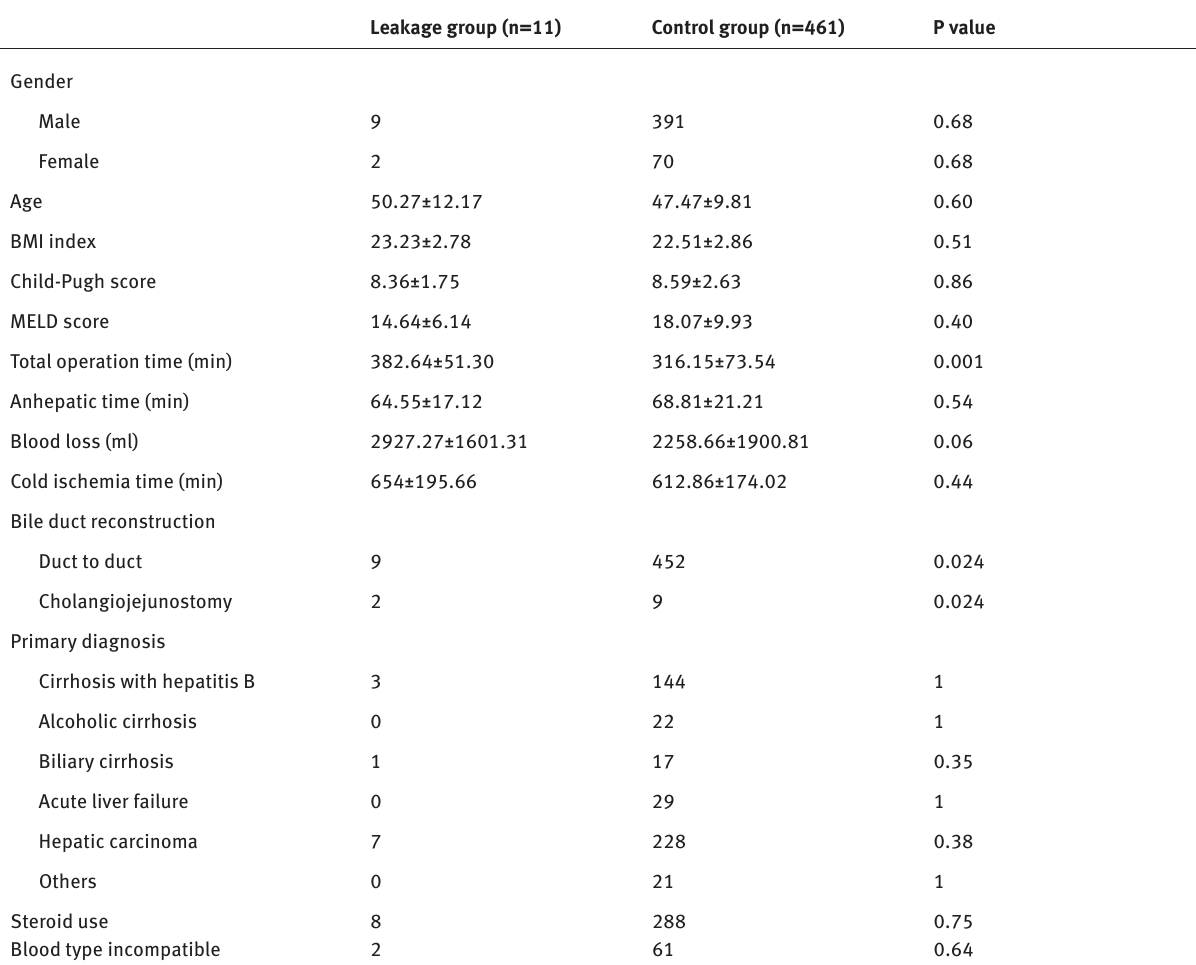
Table 1: Comparison of the characteristics of the leakage and control groups